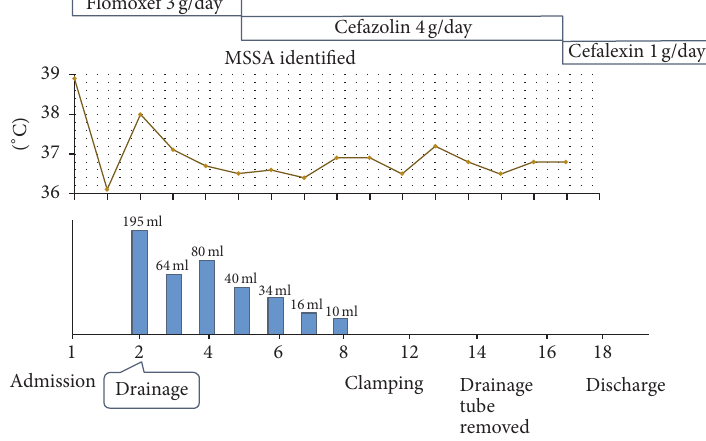
Figure 2: The treatment course.